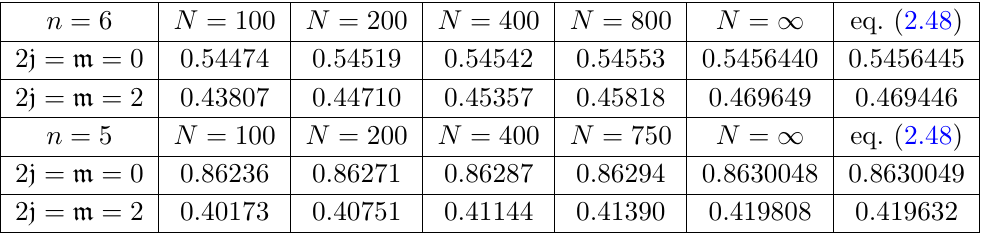
(A.4) for a variety of cases and increasing N compared 1 (cid:0) i (cid:1) m ; j + 1 given by eq. (2.48). The column \ N = 1 " was obtained by 2 2